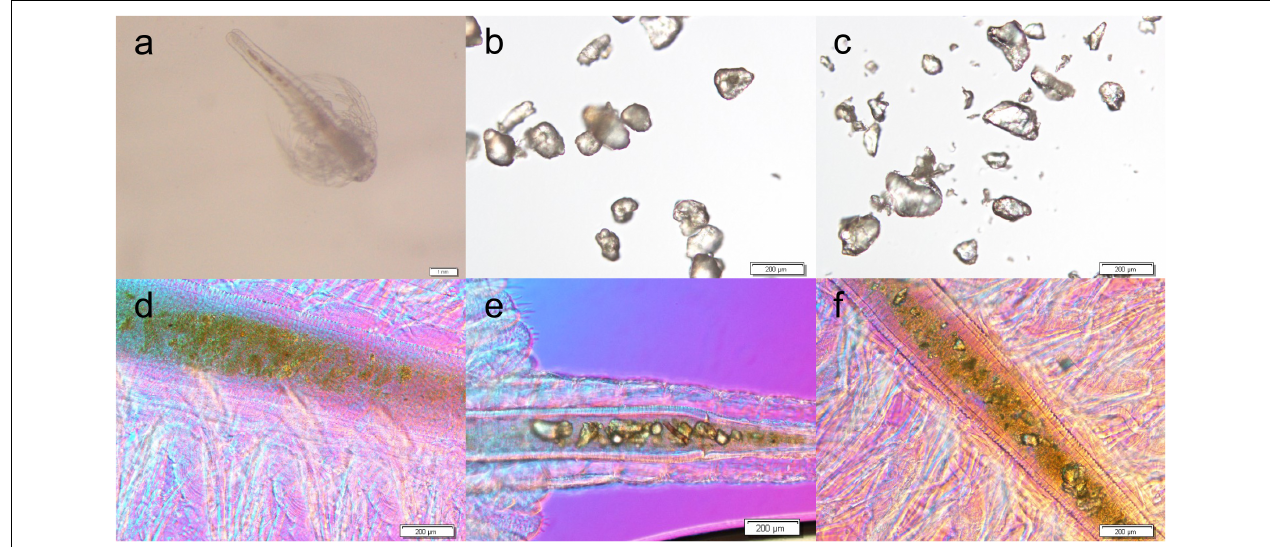
FIGURE 2 | Microscopic photos of brine shrimp (a) , PE MPs (b) , and PS MPs (c) , and brine shrimp intestines of untreated CK (d) , treated with PE (e) and treated with PS (f)